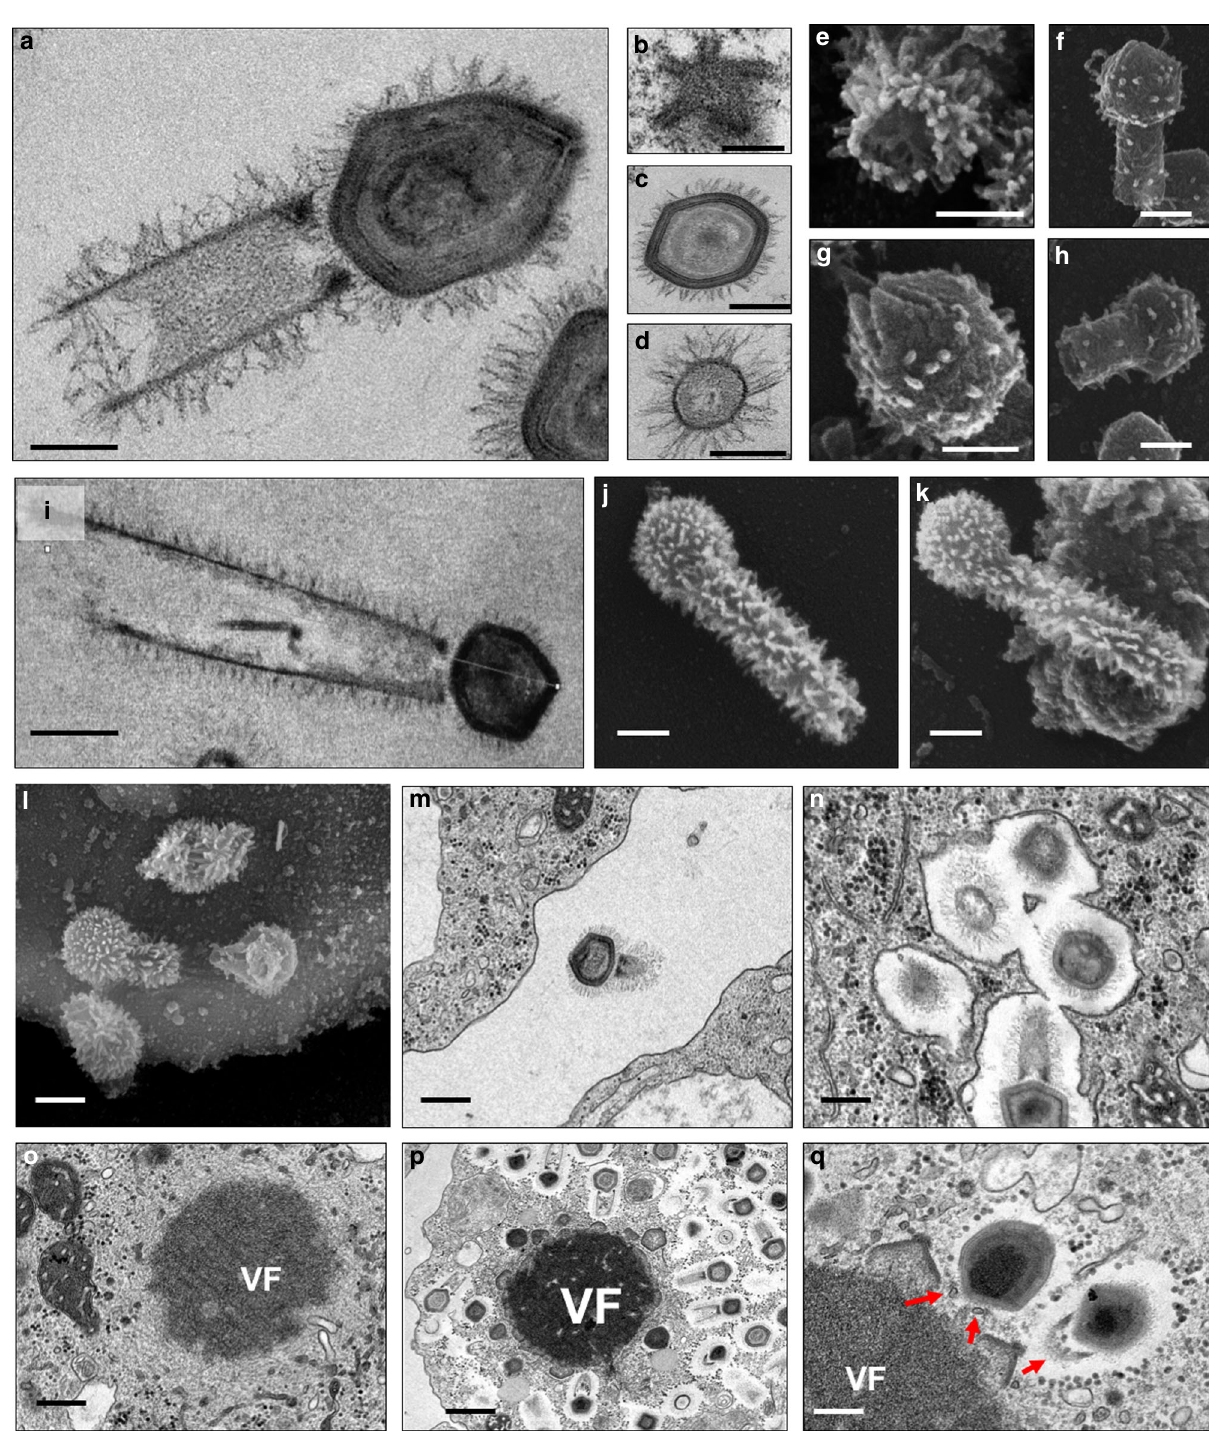
Fig. 2 Tupanvirus soda lake particles and cycle features. a Transmission electron microscopy (TEM) highlights the inner elements of the whole particle. Scale bar, 200 nm. b Star-gate vertex transversally cut. Scale bar, 100 nm. c Capsid transversally cut. Scale bar, 100 nm. d Tail transversally cut. Scale bar, 200 nm. e – h Scanning electron microscopy (SEM) of puri fi ed particles. Scale bars, 250nm. The treatment of particles with lysozyme, bromelain and proteinase-K removed most of the fi bers, revealing head and tail junction details. Super particles (>2000 nm) could be observed by TEM ( i ) and SEM ( j , k ). Scale bars, 400nm. Cycle steps are shown from l – r . l Viral particle attachment to Acanthamoeba castellanii surface; scale bar, 500 nm; m phagocytosis; scale bar, 500 nm; n particles in a phagosome; scale bar, 500 nm; o early viral factory; scale bar, 500 nm; and p , q mature viral factories. Scale bars 1 µ m and 250 nm, respectively. Arrows highlight tail formation associated with the viral factories. VF viral